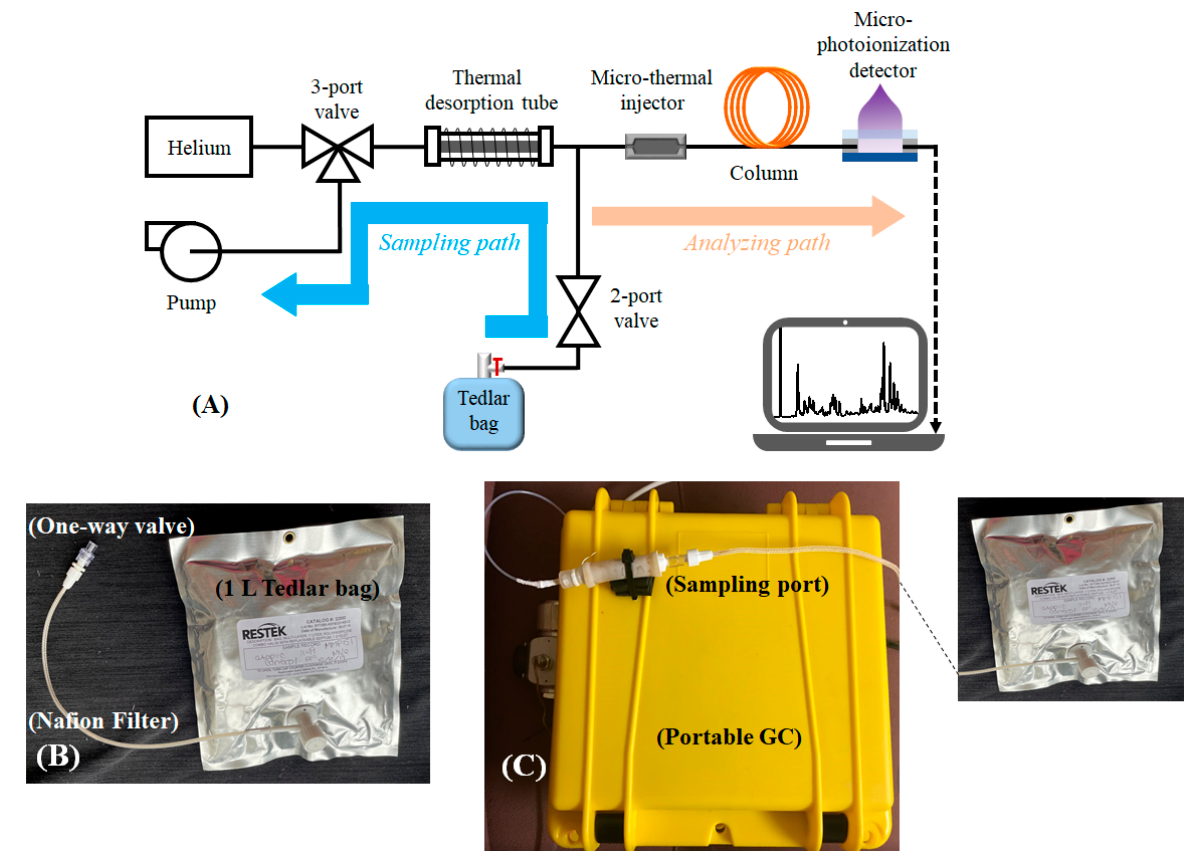
Figure 5. ( A ) Layout of the portable GC device. ( B ) During breath sampling, the subject exhales breath into a Tedlar bag (1 L) via a mouthpiece connected to one-way valve. ( C ) Photo of the portable GC, showing that a Tedlar bag is connected to the sampling port of the device.